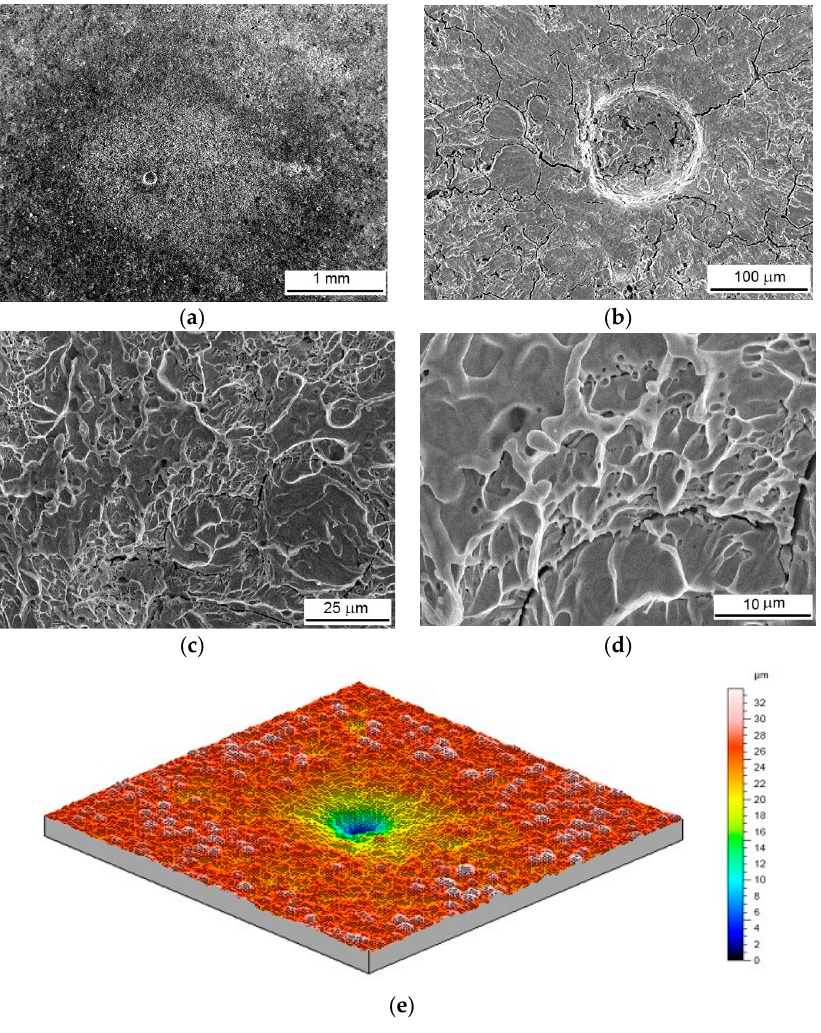
Figure 6. PS W: SEM micrographs at different magnification of the area irradiated by the laser pulse ( a – d ). Morphology of the same zone measured through the surface analyzer ( e ).